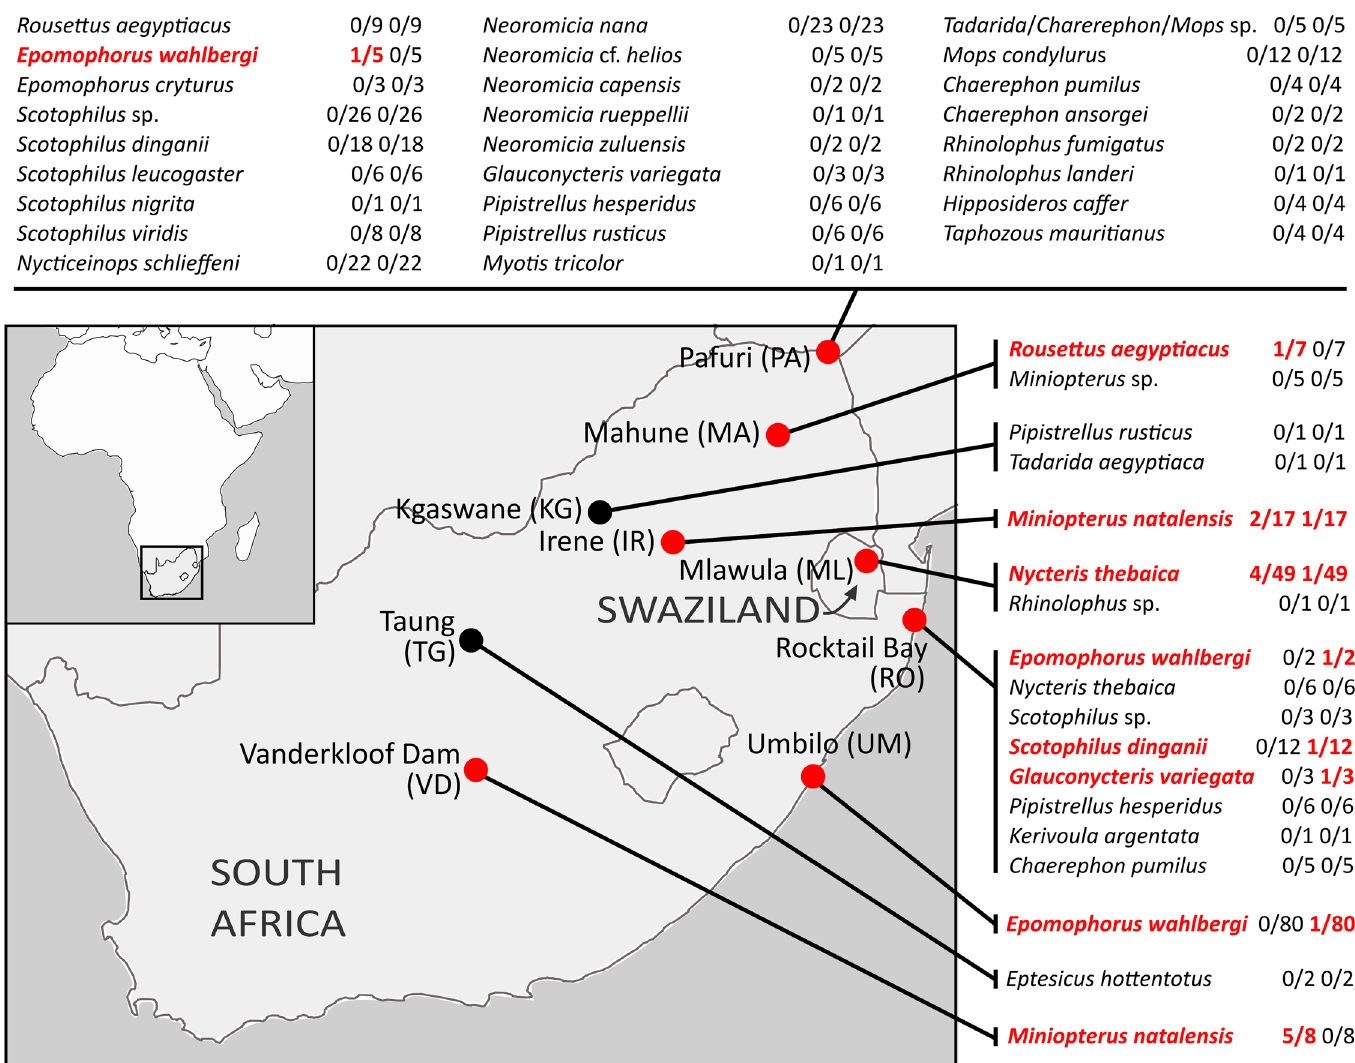
Fig 1. Detection of Bartonella and Rickettsia spp. in blood samples of bats from South Africa and Swaziland. Sampling location abbreviations are indicated in parentheses. The number of positive/tested samples is indicated for Bartonella and Rickettsia spp. respectively. Bat species that tested positive are highlighted in bold. Pafuri is located in the northern region of the Kruger National Park and ‘ Kgaswane ’ refers to the Kgaswane Mountain Nature Reserve. The map was drawn using the freeware PanMap software: